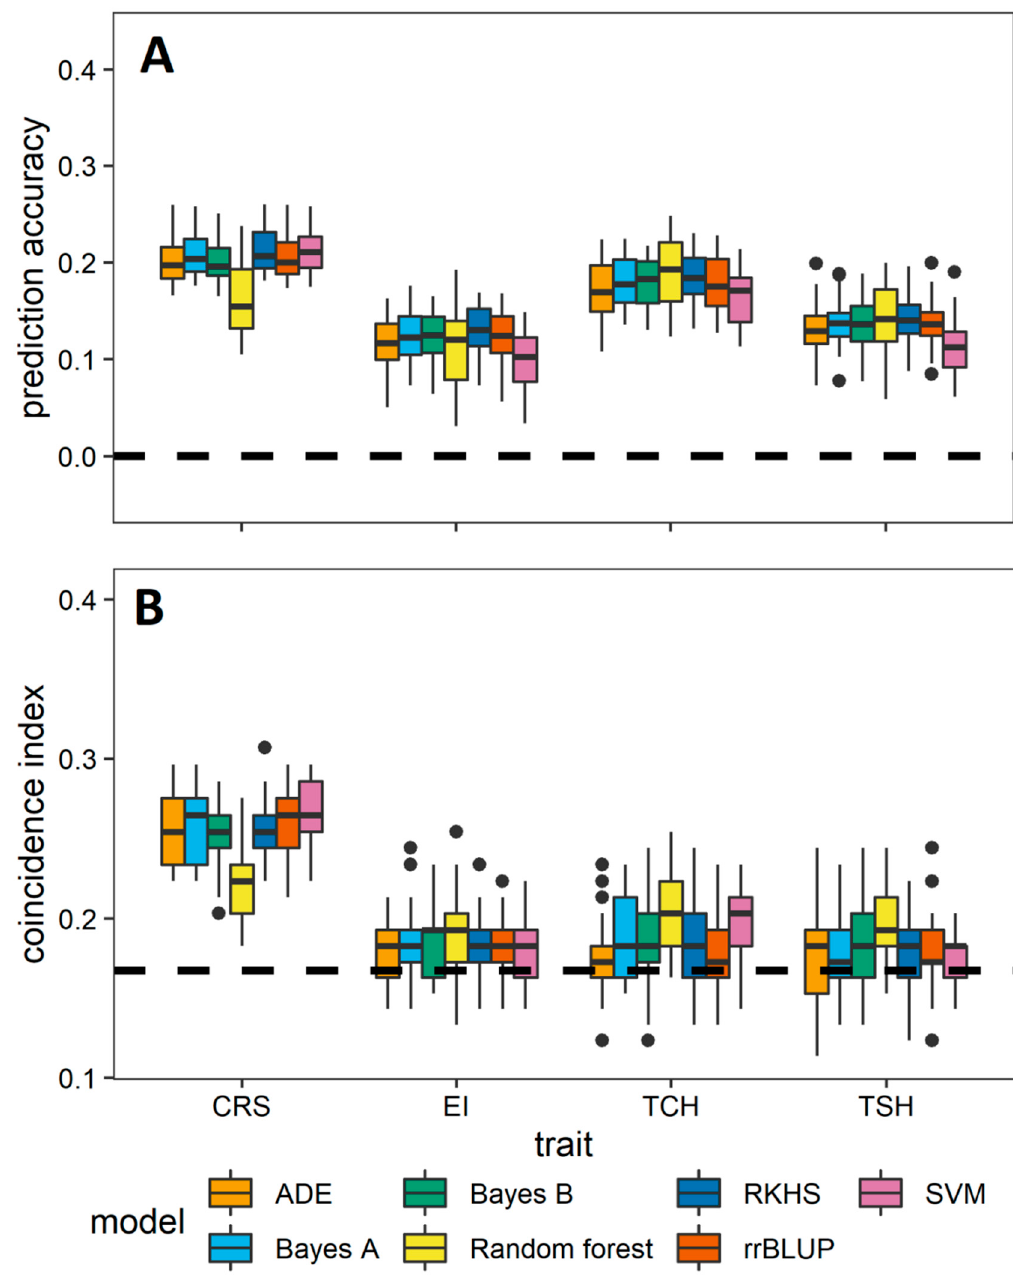
Figure 2. Prediction accuracy ( A ) and coincidence index ( B ) of the genomic estimated breeding estimated value (GEBV) of four secondary traits for fivefold cross-validation (fivefold CV) of seven genomic selection (GS) methods. The fivefold CV was performed by randomly selecting four-fifths of the individuals for training and reaming a fifth as the validation population for the plant cane.